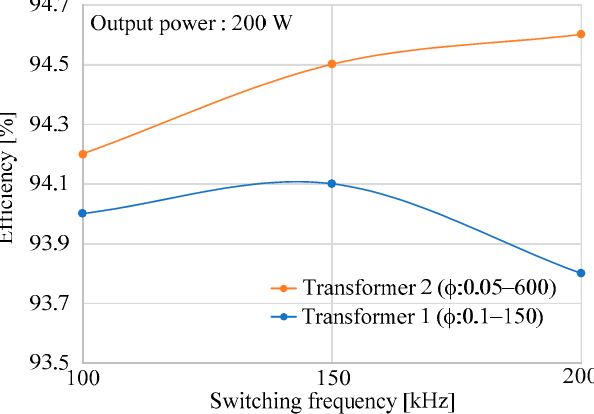
Figure 12. Comparison of conversion efficiency when switching frequency is changed.